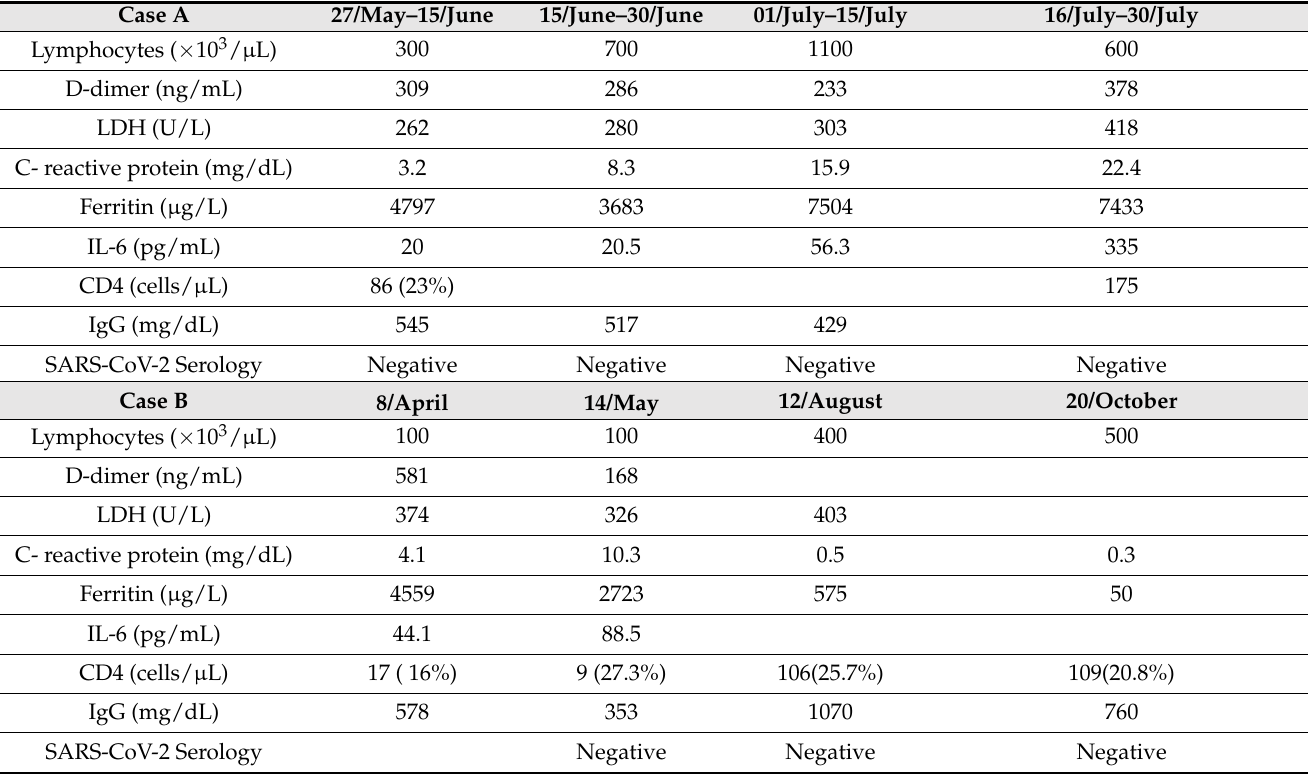
Table 1. Clinical values of patients along the infection. (Reference values: Linfocytes (1.2–5.2), D-Dimer (0–250), LDH (135–225), C-Reactive Protein (0.0–0.5), Ferritin (22–274), IL-6 < 4.3, CD4 (300–1400), IgG